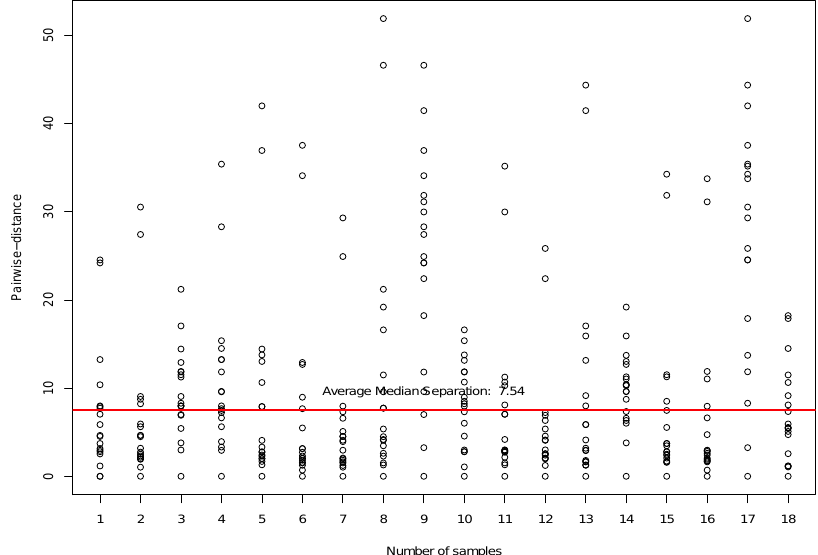
Figure 11. Pairwise-distances for temperature sensors in a range of 100 km from the coordinates of London, UK, in Dataset 2, considering only sensors with correlation r ≥ 0 . 8